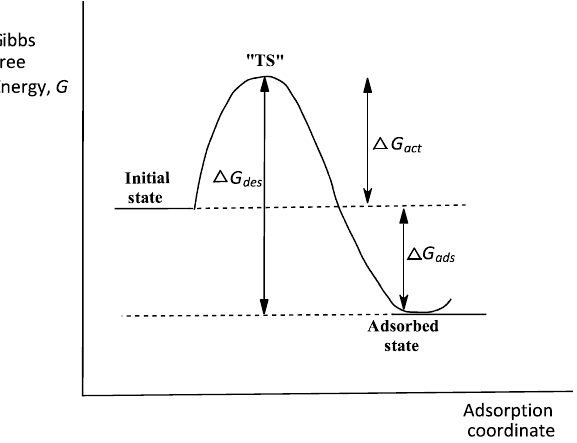
Figure 5. A two-dimensional Gibbs free energy diagram in which an adsorption process is treated as a chemical reaction, showing the energy barriers for adsorption and desorption with a hypothetical transition state “TS”. Desorption is seen as the microscopic reverse of adsorption. Adapted, with permission, from the copyright holder, M. A. Hubbe (see 74